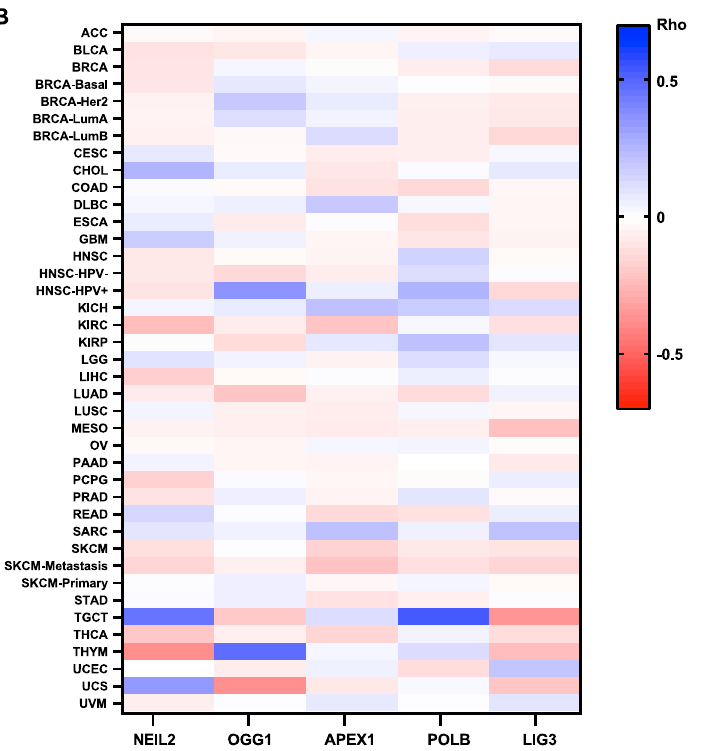
Figure 3. BER gene landscape and its impacts on macrophage infiltration in tumor microenvironment. ( A ) Heatmap of overexpression of BER genes from 40 types of cancer and 17 different BER repair genes expression in tumor cells versus macrophage infiltration. ( B ) Five representative genes (NEIL2, OGG1, APEX1, POLB, DNA LIG3) selected to demonstrate the correlation of overexpression of those repair genes and M2 infiltration in tumor microenvironment. Rho represents correlation coefficient. All data were extracted from TCGA data set and analyzed using TIMER 2.0 using CIBERSORT.